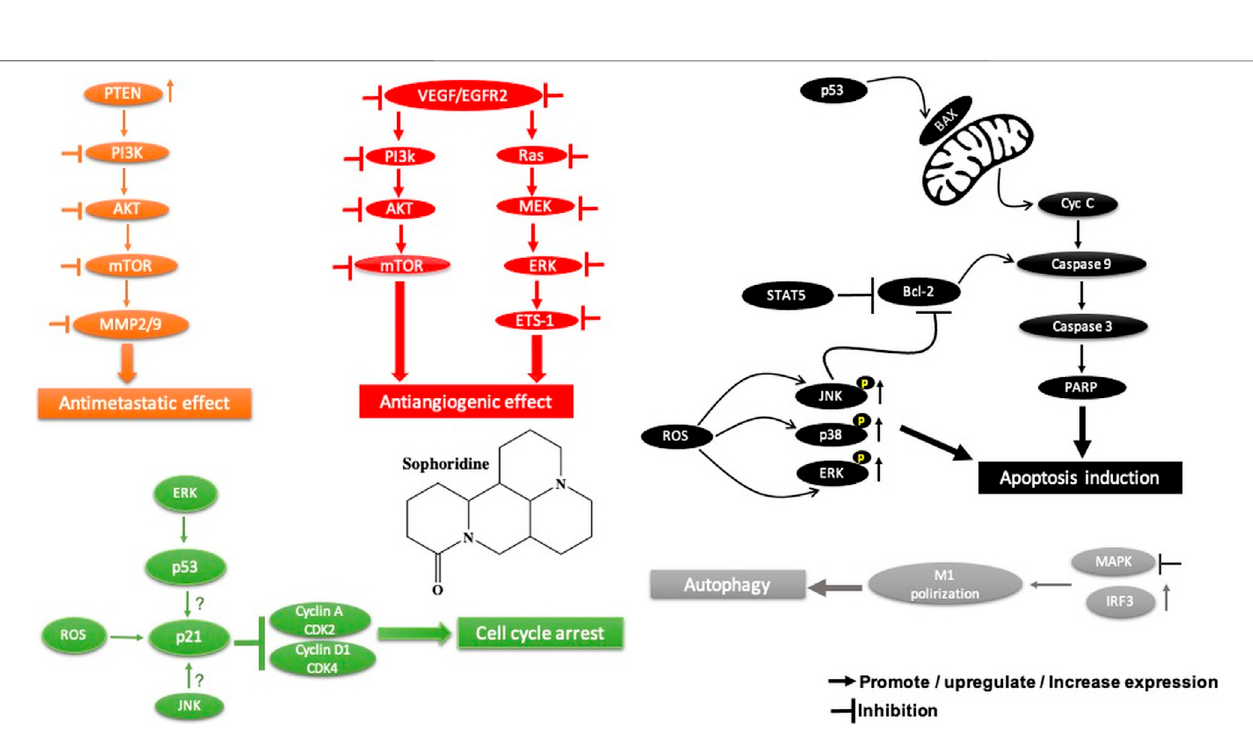
FIGURE 3 | Main mechanism of sophoridine against cancer.